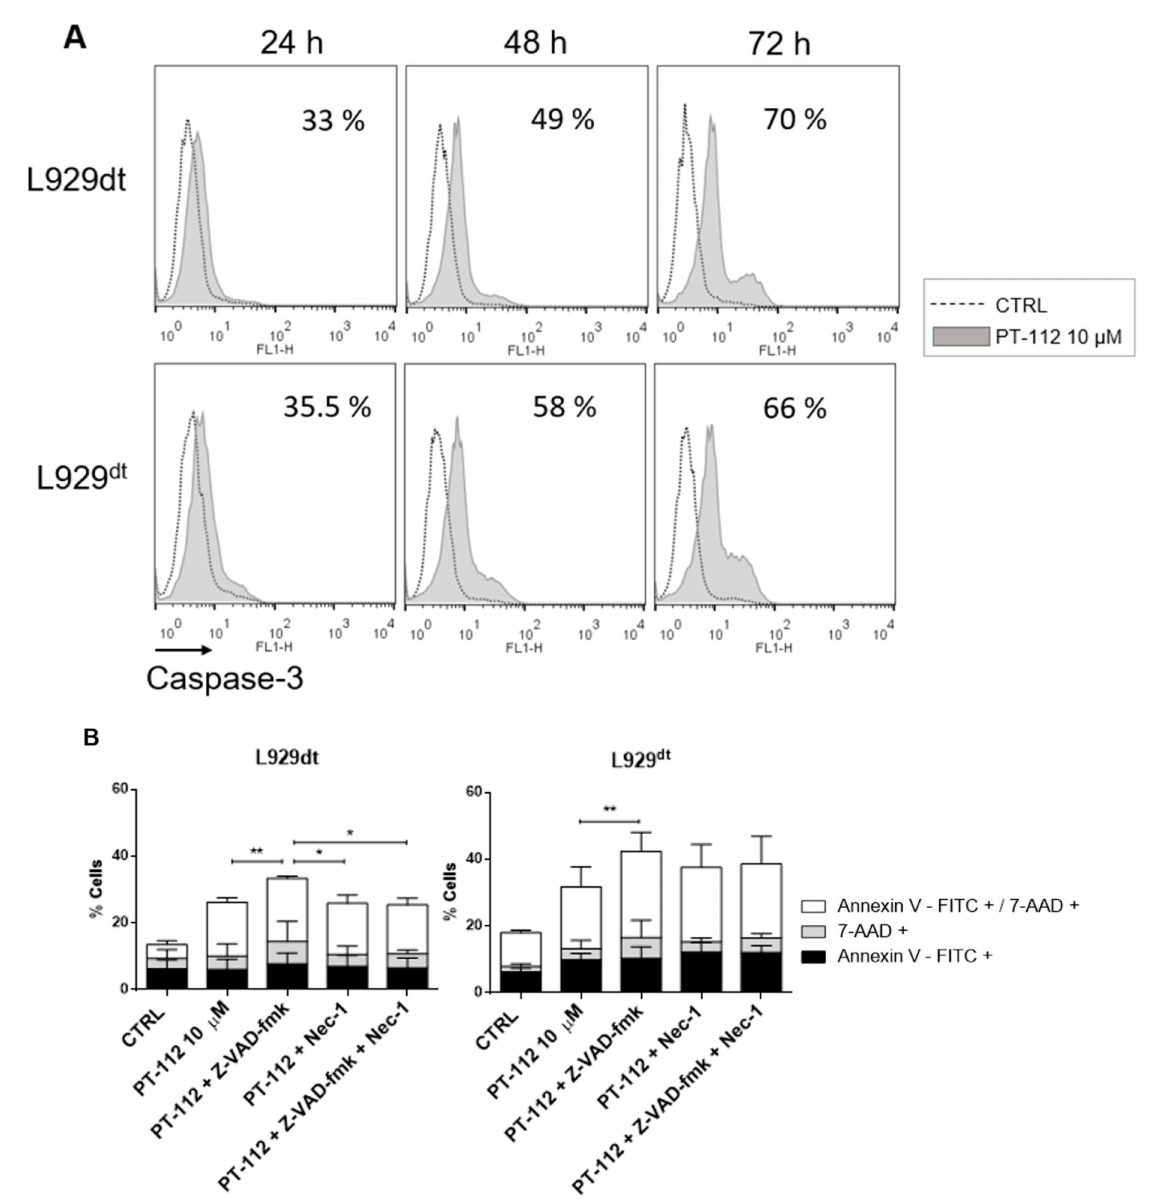
Figure 3. Caspase-3 activation by PT-112 and effect of apoptosis and necroptosis inhibitors. ( A ) Levels of caspase-3 activation upon treatment with PT-112. 3 × 10 4 cells were treated with 10 µ M of PT-112 for 24–72 h. Then, cells were incubated with anti-cleaved caspase-3 labelled with FITC dye and analyzed by flow cytometry. The numbers in each box represent the percentage of cleaved caspase-3 compared to untreated cells. ( B ) Cytotoxicity analysis of PT-112 combined with Z-VAD-fmk and/or necrostatin-1 inhibitors. Cells were pretreated for 1 h with or without pan-caspase or/and necroptosis inhibitors and then, incubated with 10 µ M of PT-112 for 48 h. Flow cytometry analysis was performed using annexin-V-FITC and 7-AAD staining. Results are shown as mean ± SD of 3 independent experiments performed in duplicate. Statistical significance is depicted in the graphics. *, p < 0.05; **, p <